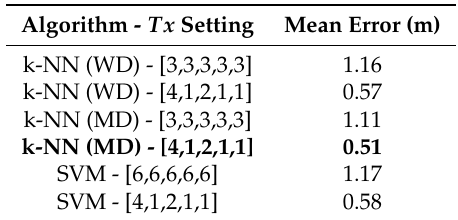
Table 7. Mean error for k-NN (with k = 5) using weighted distance (WD) and mode (MD); and SVM (with a quadratic polynomial kernel function) with the same and the most relevant transmission power level ( Tx ). Best results are shown in